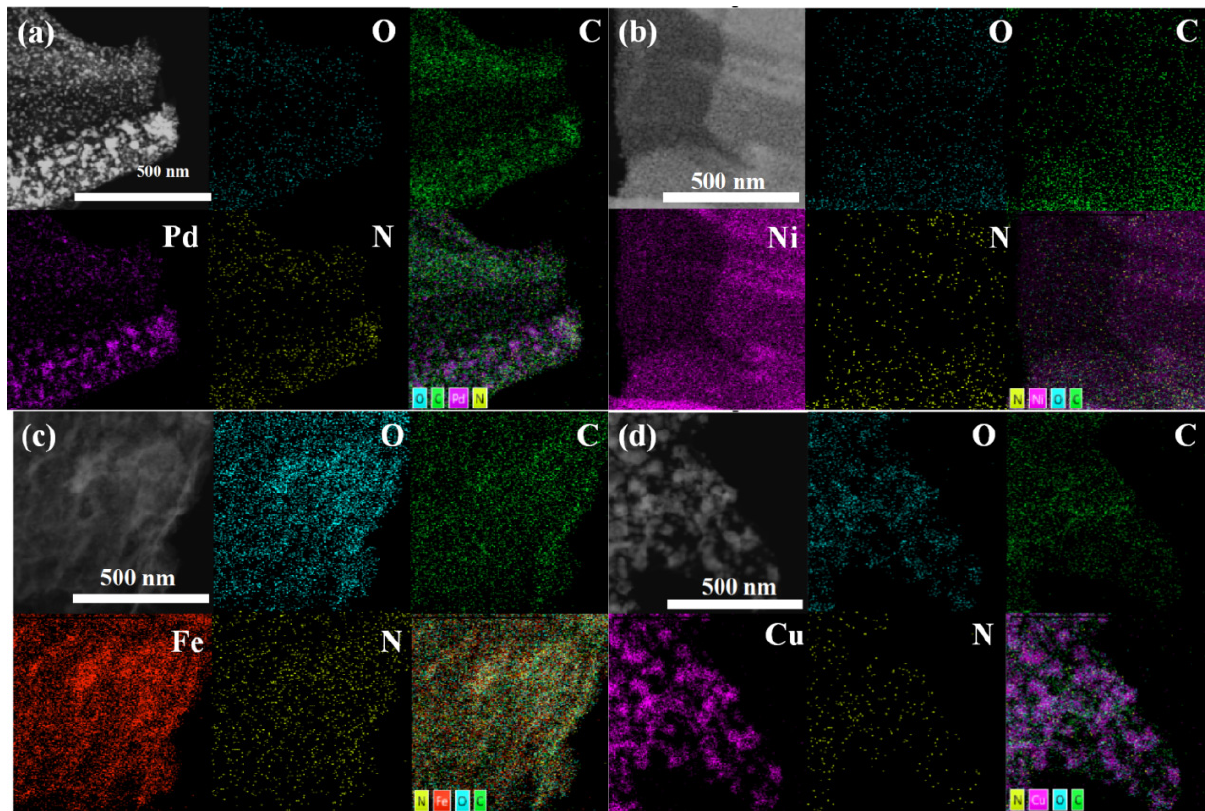
Figure 2. The SEM and corresponding elemental mapping of Pd-NC ( a ), Ni-NC ( b ), Fe-NC ( c ), Cu-NC ( d ). The HRTEM images of Cu-NC, Fe-NC, Ni-NC, and Pd-NC are shown in Figure 3. The crystal lattice spacing of 0.25 nm, 0.194 nm and 0.173 nm in Figure 3A could